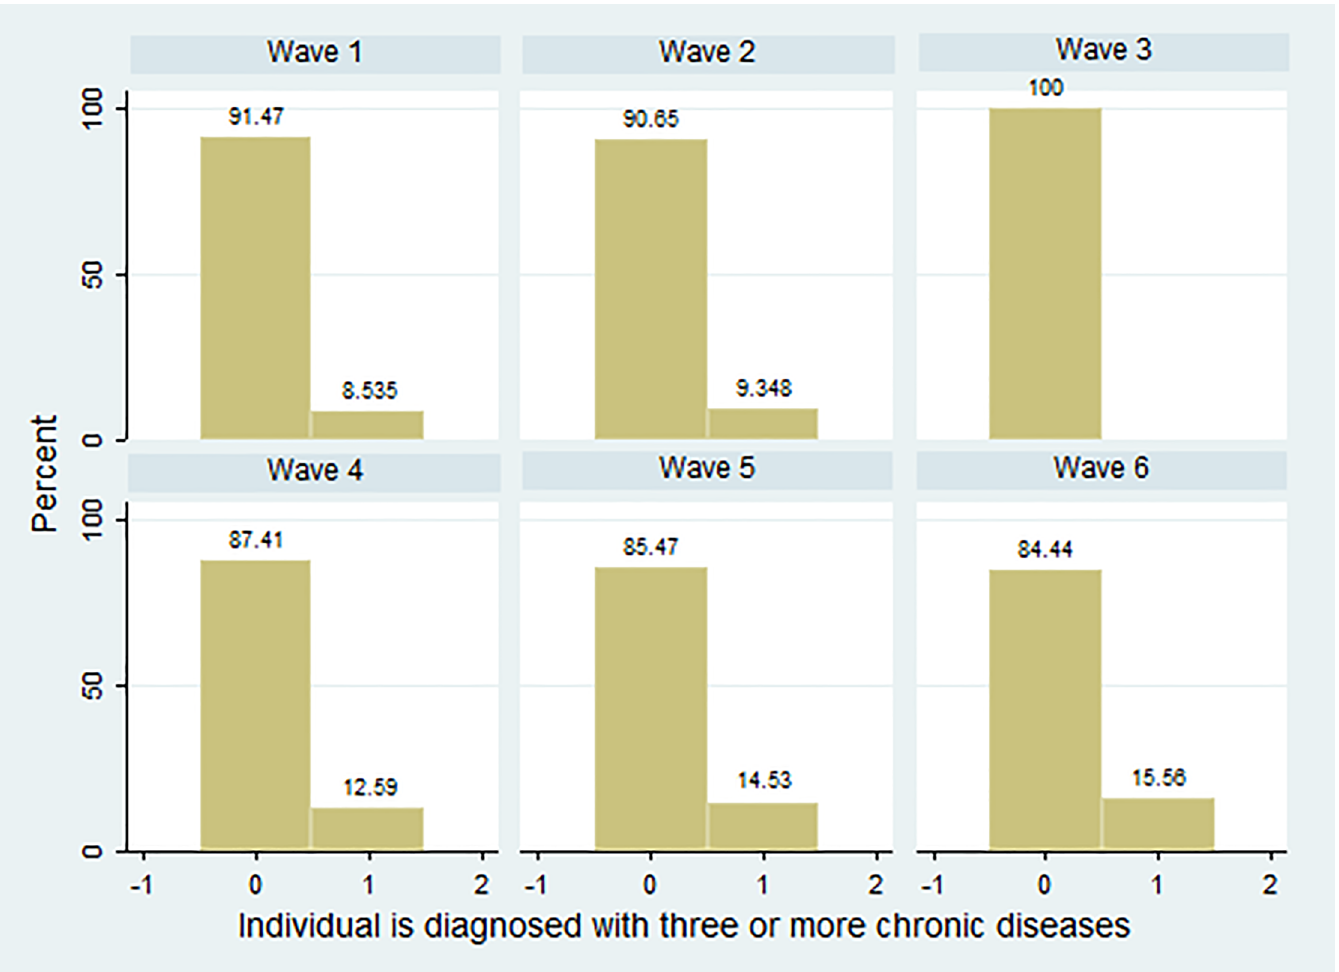
Fig 1. Distribution (percentages) of Chronic by SHARE Wave. Source : Authors’ calculations based on easySHARE release 6.0.0 (Waves 1 to 6: 2004–2015). Population aged (cid:21) 50. Macro-areas: (i) Nordic (Denmark and Sweden), (ii) Continental (Austria, Belgium, France, Germany and Switzerland), (iii) Southern (Italy and Spain). Notes : Number of chronic diseases is not asked in Wave